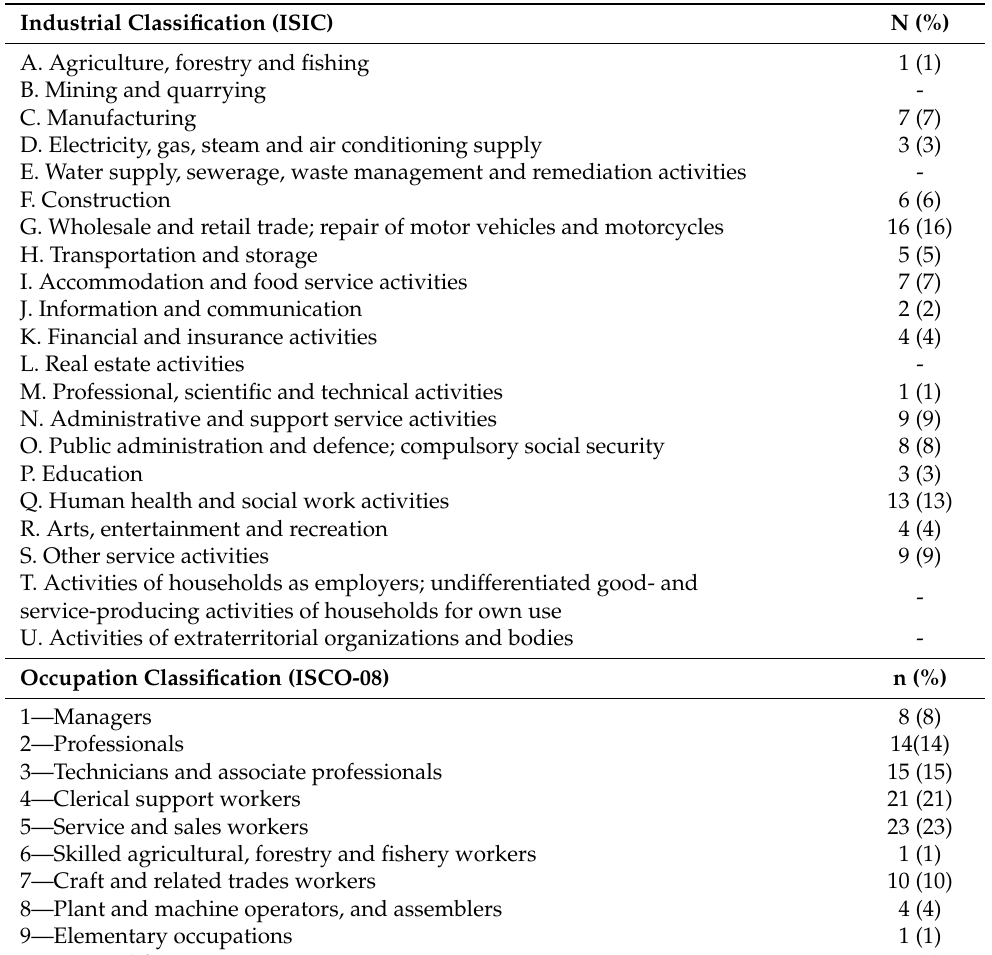
Table 3. Productive field of employment and occupational activities performed by CF employed